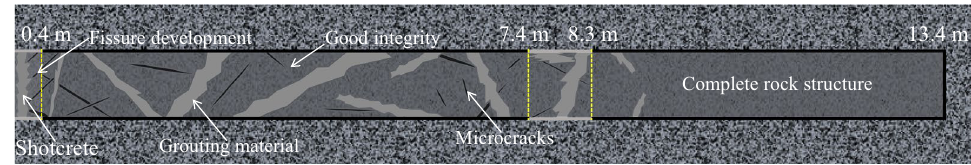
Fig. 28 Sketch drawing of borehole detection of surrounding rock after strengthening